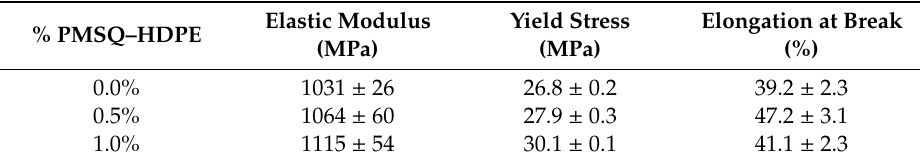
Table 1. Tensile mechanical properties of high-density polyethylene–polymethylsilsesquioxane (HDPE–PMSQ) nanocomposites [19].